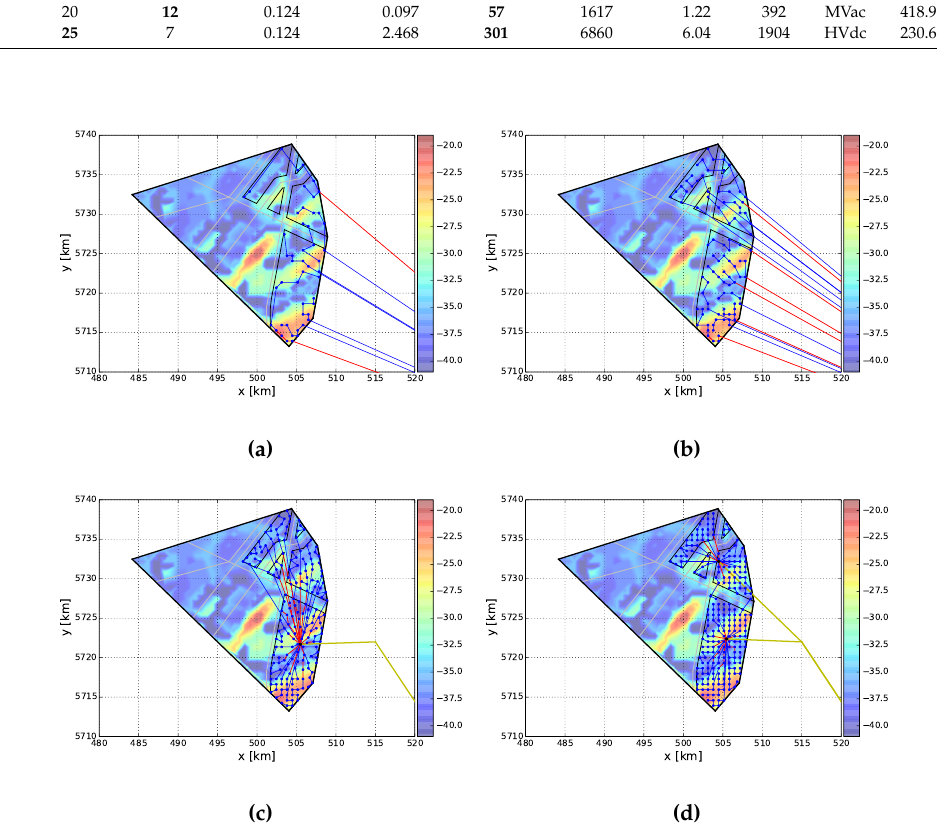
Figure 21. Layouts with the best NPV values. Blue, purple and black circles represent, respectively, the 8 MW turbines, HVac and HVdc substations. Gray lines are existing pipelines and telecom cables, blue and red lines are the collection system cables and yellow lines are the exporting HVdc